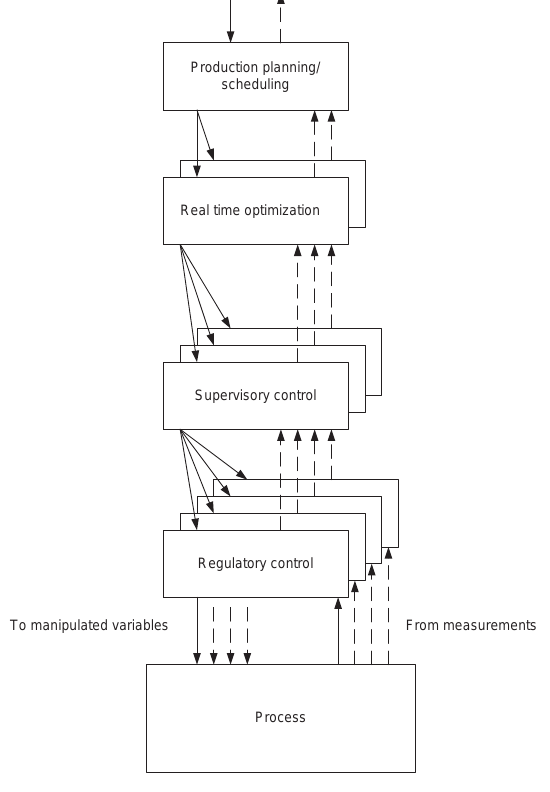
Figure 1: Control hierarchy in a large industrial plant.